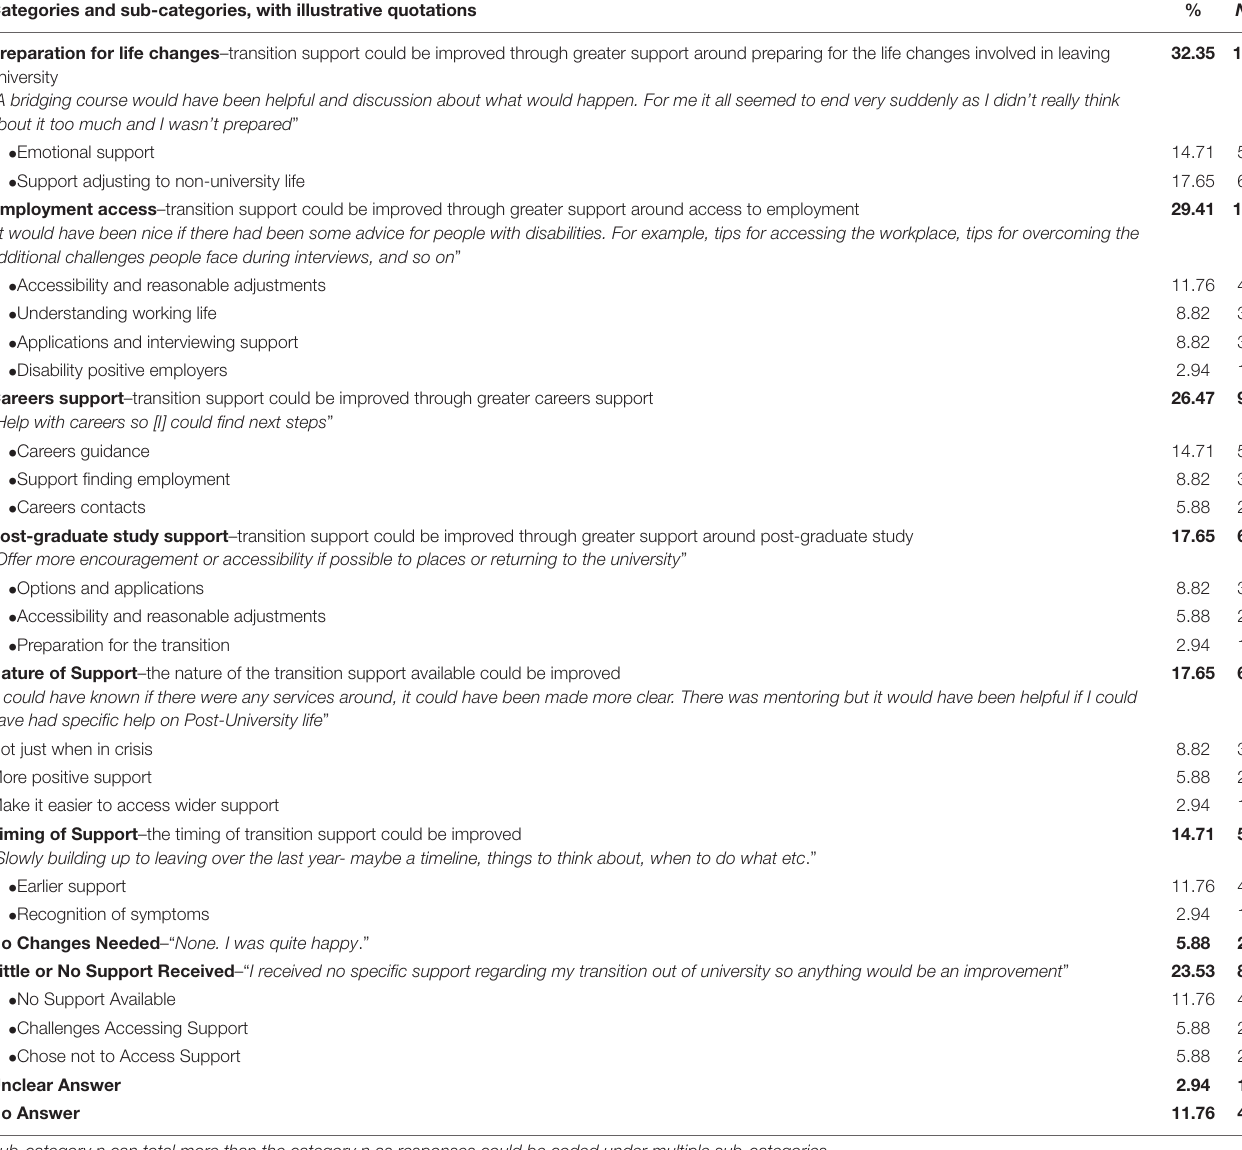
TABLE 3 | Content analysis of participants’ suggestions for transition support additions or improvements, showing categories (in bold) and sub-categories (bullet pointed). Categories and sub-categories, with illustrative quotations %